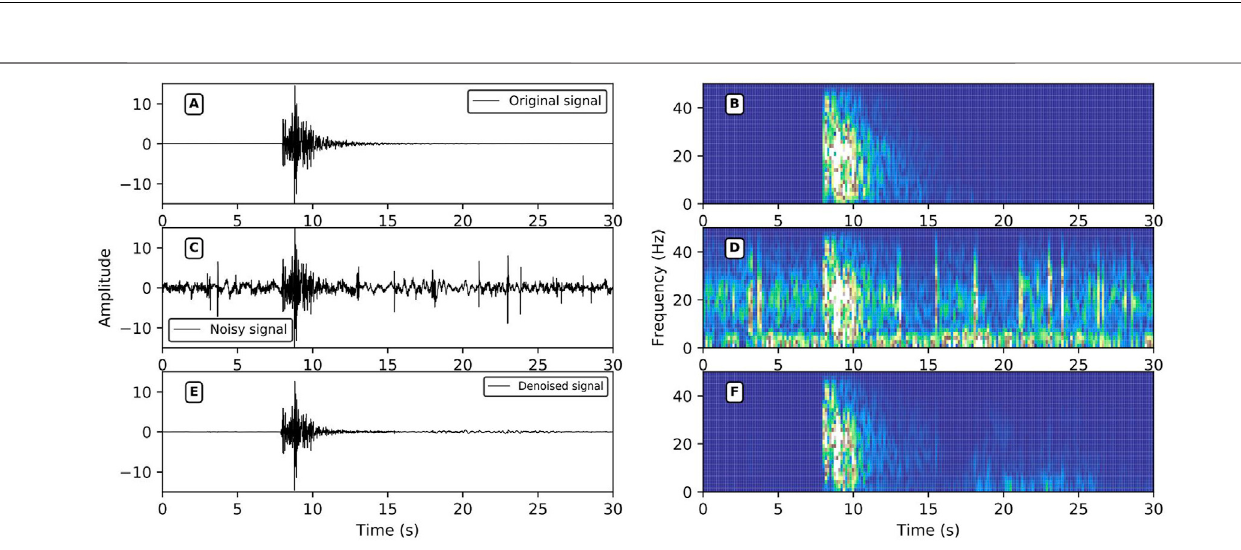
Frontiers in Earth Science |